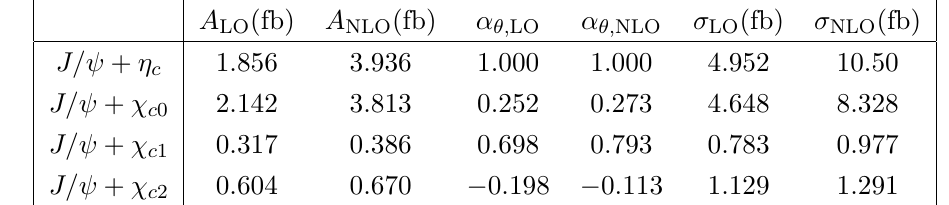
√ s = 10 . 6 GeV. A and α θ are the coefficients